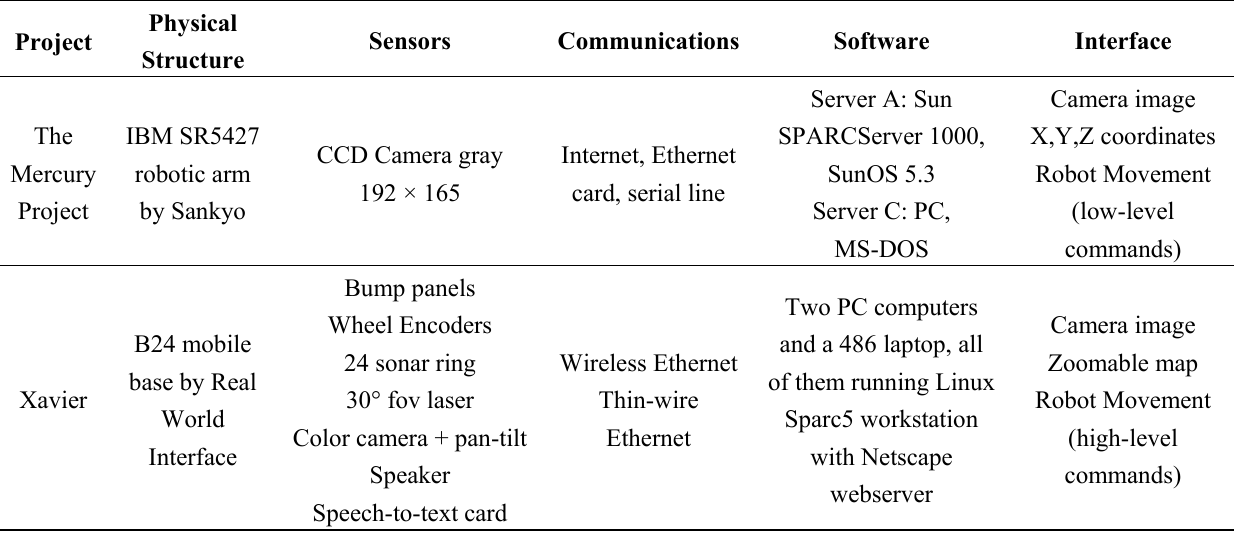
Table 2. Two networked telerobots (one non-mobile and the other mobile) as examples of the usual kind of components that are found in these